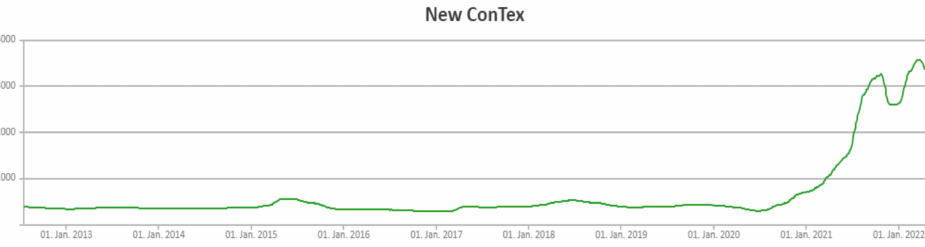
Figure 1. ‘New ConTex’ index for the period from 1 January 2013–10 July 2022, Source: [53].